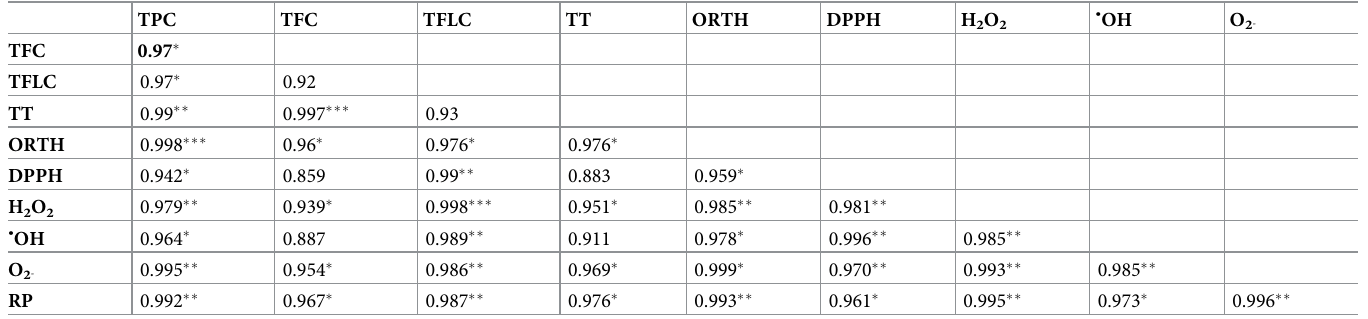
Table 5. Correlation matrix between the quantified phytochemicals and antioxidant activities. TPC TFC TFLC TT ORTH DPPH H 2 O 2 • OH O 2 -